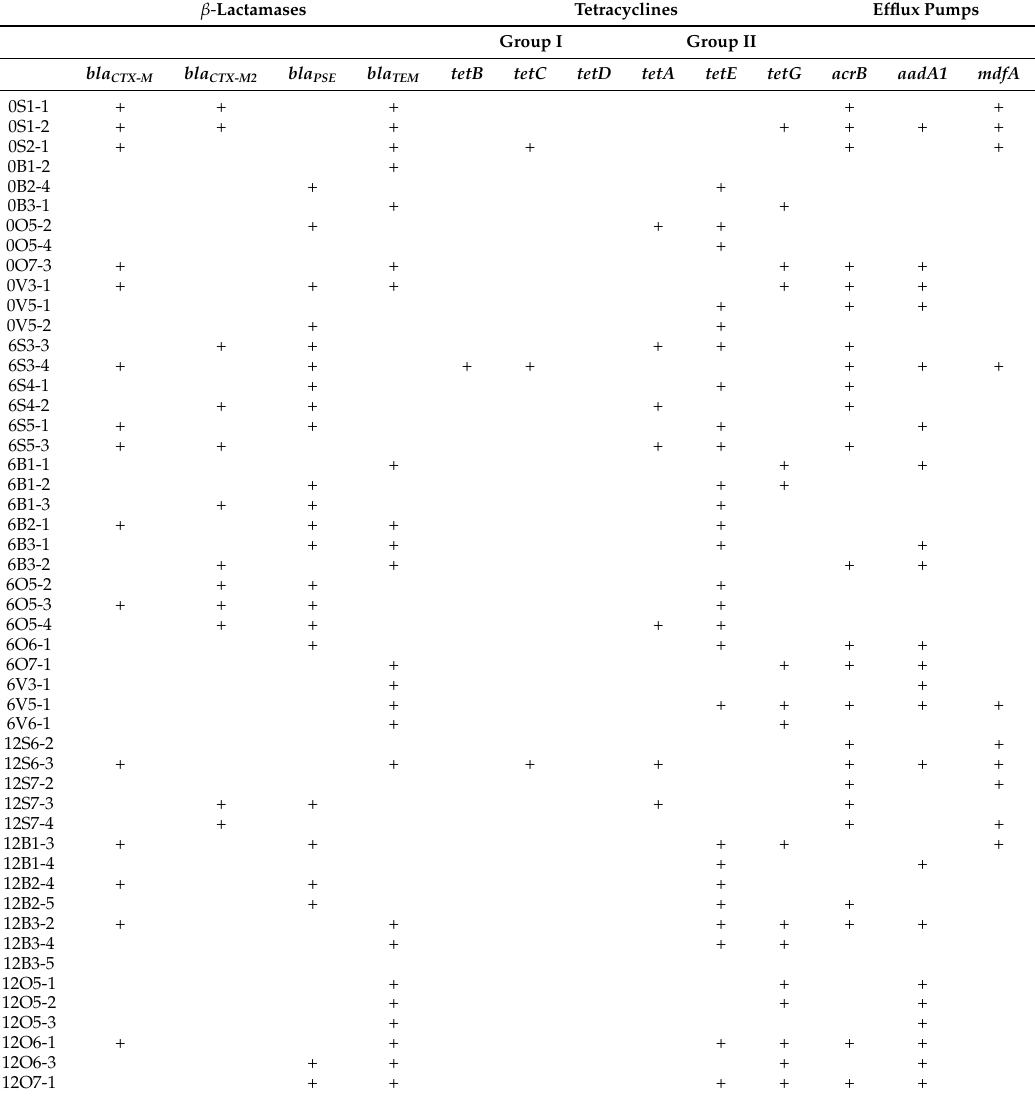
Table 3. Genetic determinants of